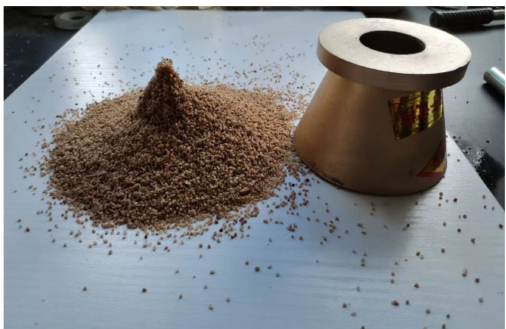
Figure 9. Determination of the water absorption of particles with sizes of 0.15~2